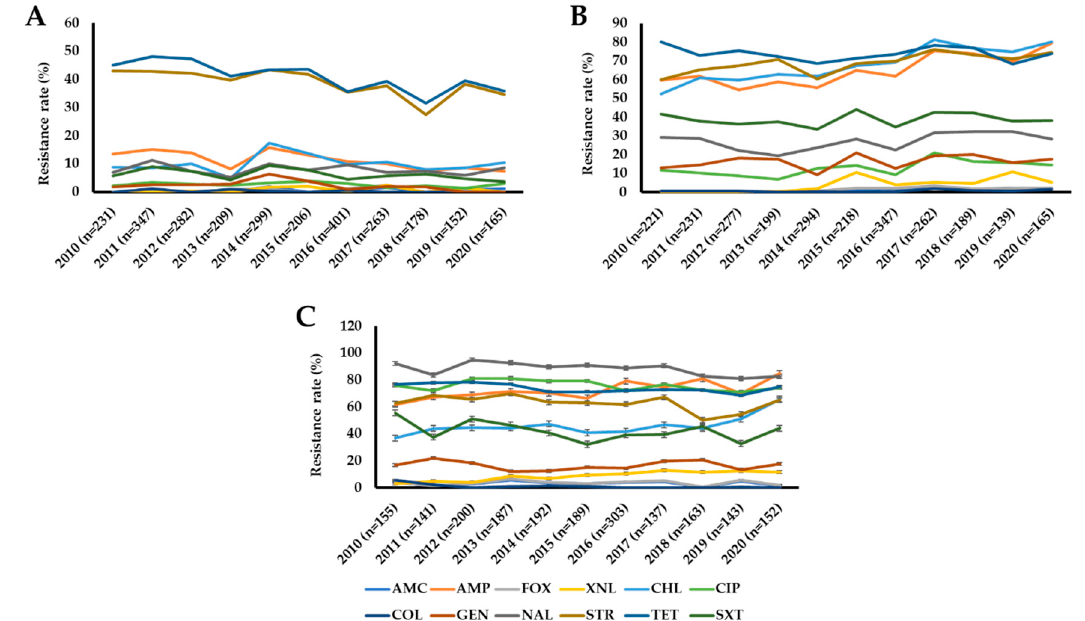
Figure 1. Antimicrobial resistance trends of E . coli isolates recovered from cattle ( A ), pigs ( B ), and chickens ( C ) in Korea from 2010 to 2020. Abbreviations: AMC, amoxicillin/clavulanic acid; AMP, ampicillin; CHL, chloramphenicol; CIP, ciprofloxacin; COL, colistin; FOX, cefoxitin;